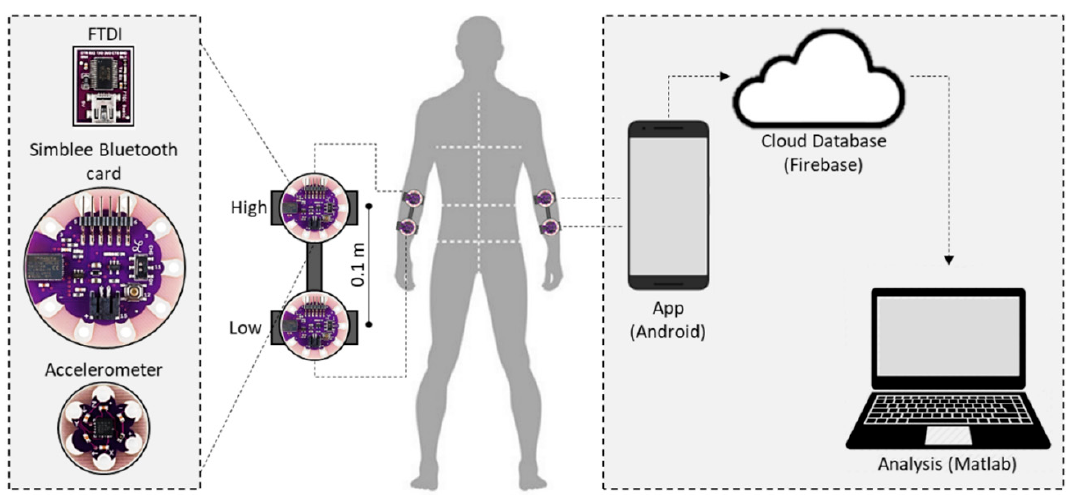
Figure 1. Smart wristbands used to measure the linear and angular acceleration of the subject’s arms in three axes. Data are uploaded through a network consisting of a smartphone that receives the data and then uploads it to a database on the cloud for subsequent analysis using a MATLAB ® script.